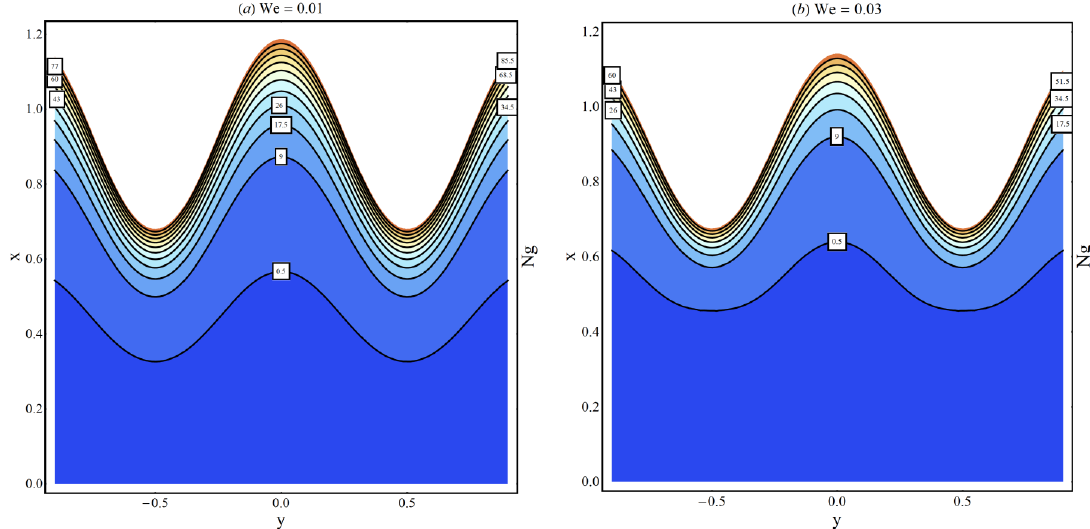
Figure 13. Entropy lines at two different We : (a) We = 0.01 and (b) We = 0.03